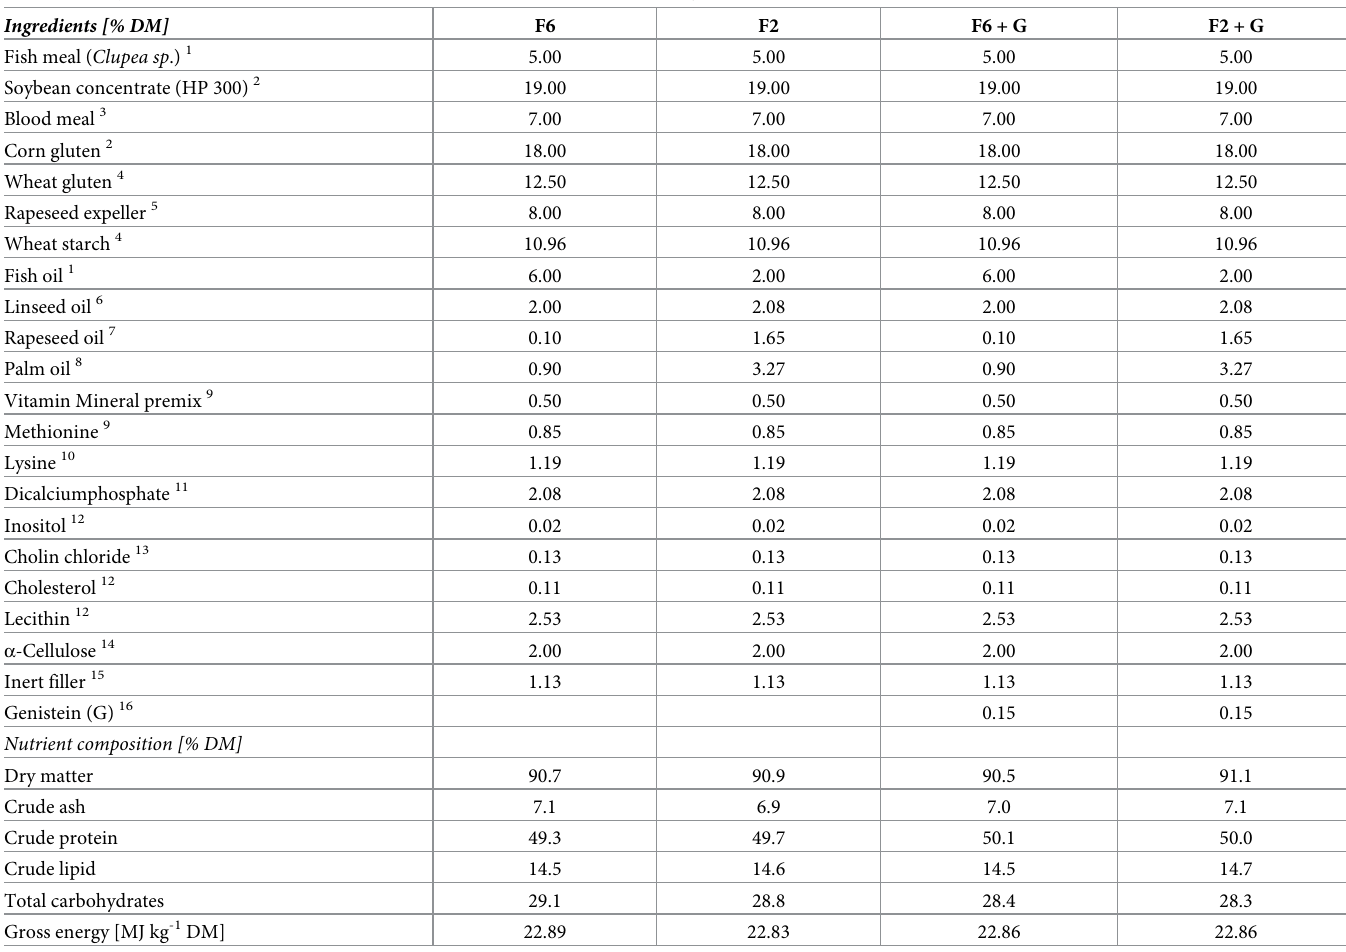
Table 1. Ingredients and nutrient composition (percentage of dry matter: % DM) of the experimental diets. F6 and F2 are the control diets with 6% and 2% DM fish oil, respectively. +G indicates the supplementation of the control diets with 0.15% DM genistein. Ingredients [%